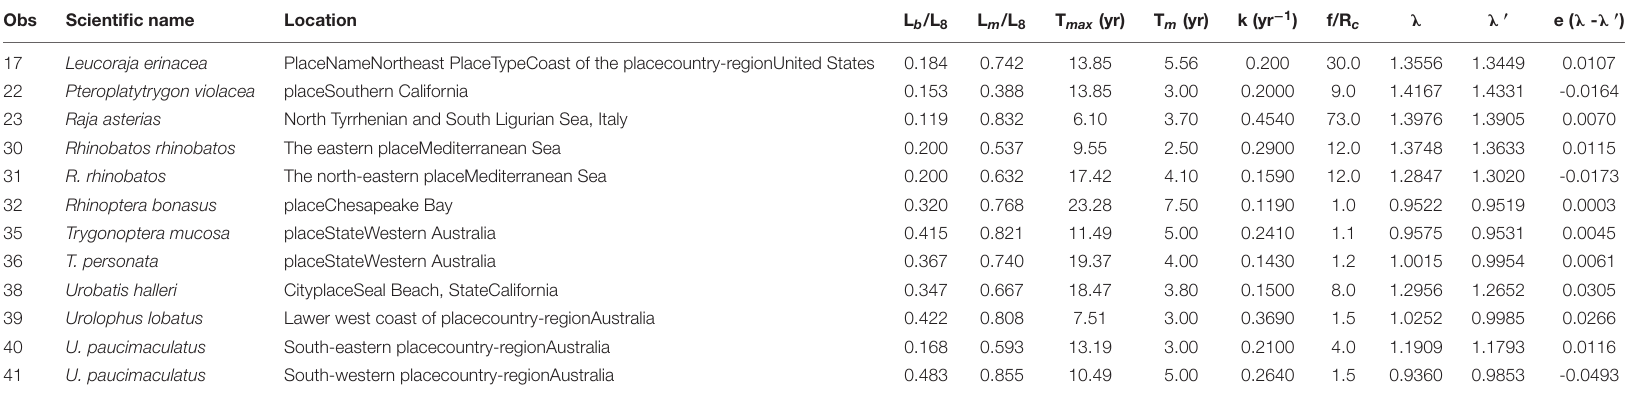
TABLE 3C | Life history parameters and estimated finite rate of population increase for the stocks of skates and rays in group 3.